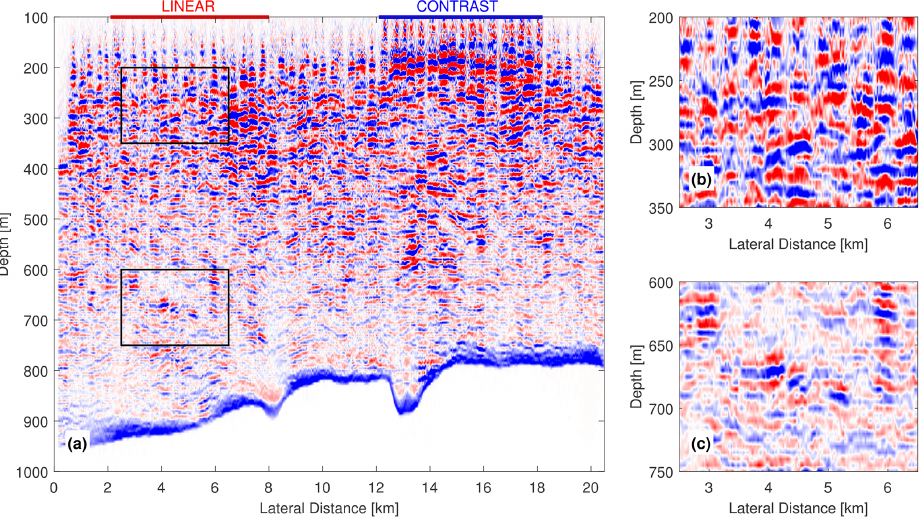
Figure 6. (a) An example of a crossline image (crossline #18200). Panels (b) and (c) are closeup views of the regions shown in (a) for two different depths. The data collection dates span from August 2002 to February 2003. The red line at top marks the linear acquisition period, while the blue line marks the contrast